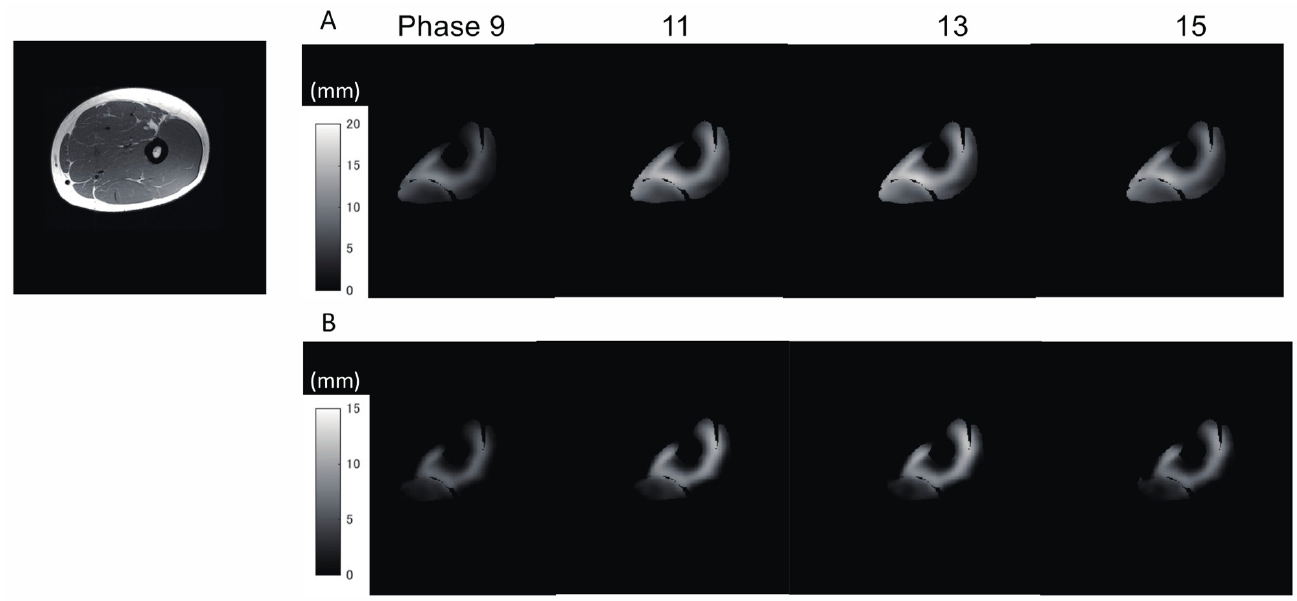
Figure 3. A typical example of the temporal changes in total ( A ) and Z-axis ( B ) displacements in one subject at phase 9, 11, 13, and 15 (the force onset was at phase 9 and the peak force was generated in phase 13). The gray scale represents the distribution of the magnitude of displacement.